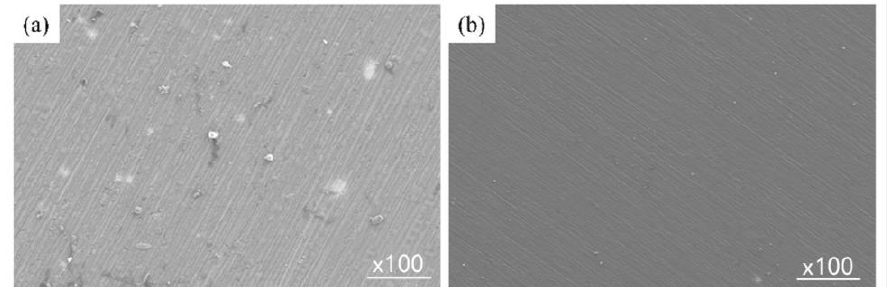
Figure 6. Surface morphology after soaking in weak alkaline solution for 20 days: ( a ) TD film ( b ) TTTD film.